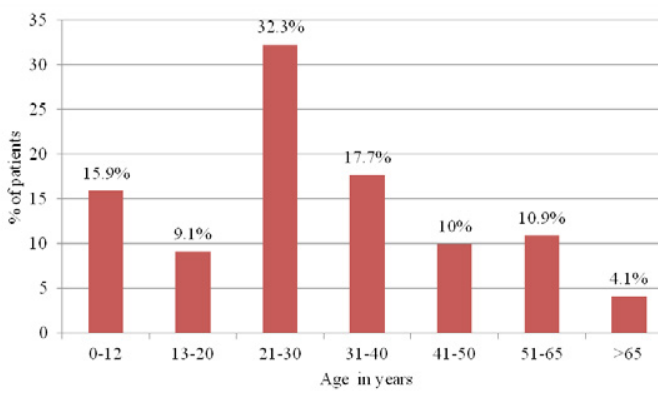
Figure 1 . Age distribution of patients Type of ocular injuries